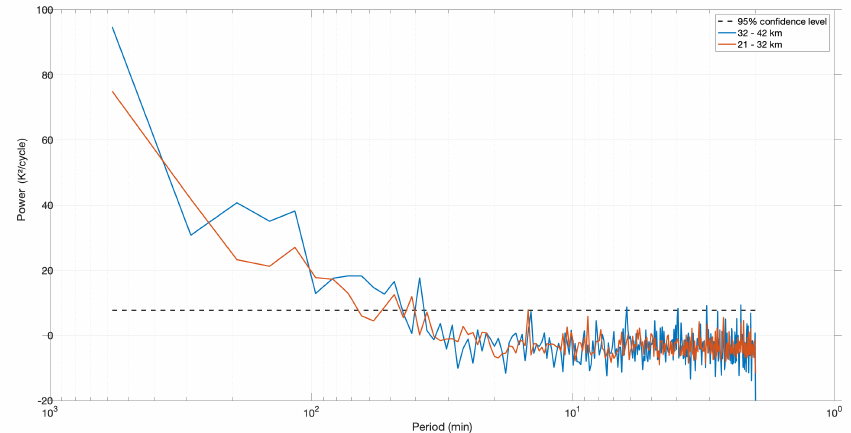
Figure 4. Mean Fourier spectrum of lidar data for altitude range [21–32] km in blue and [32–42] km in red. The black dashed line gives the 0.95 confidence level.